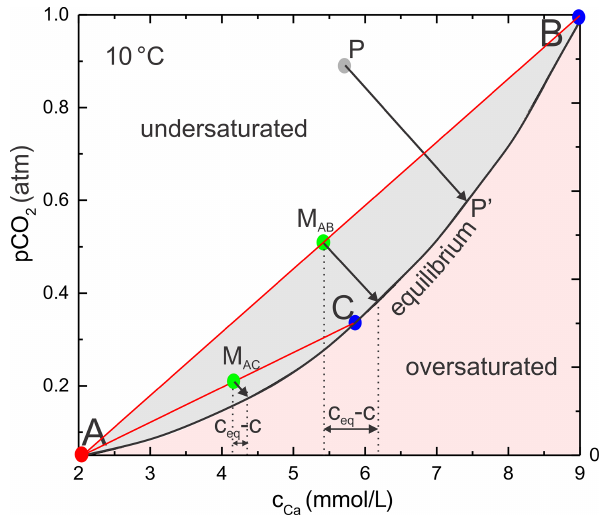
Figure 3. Processes in mixing corrosion (MC); see